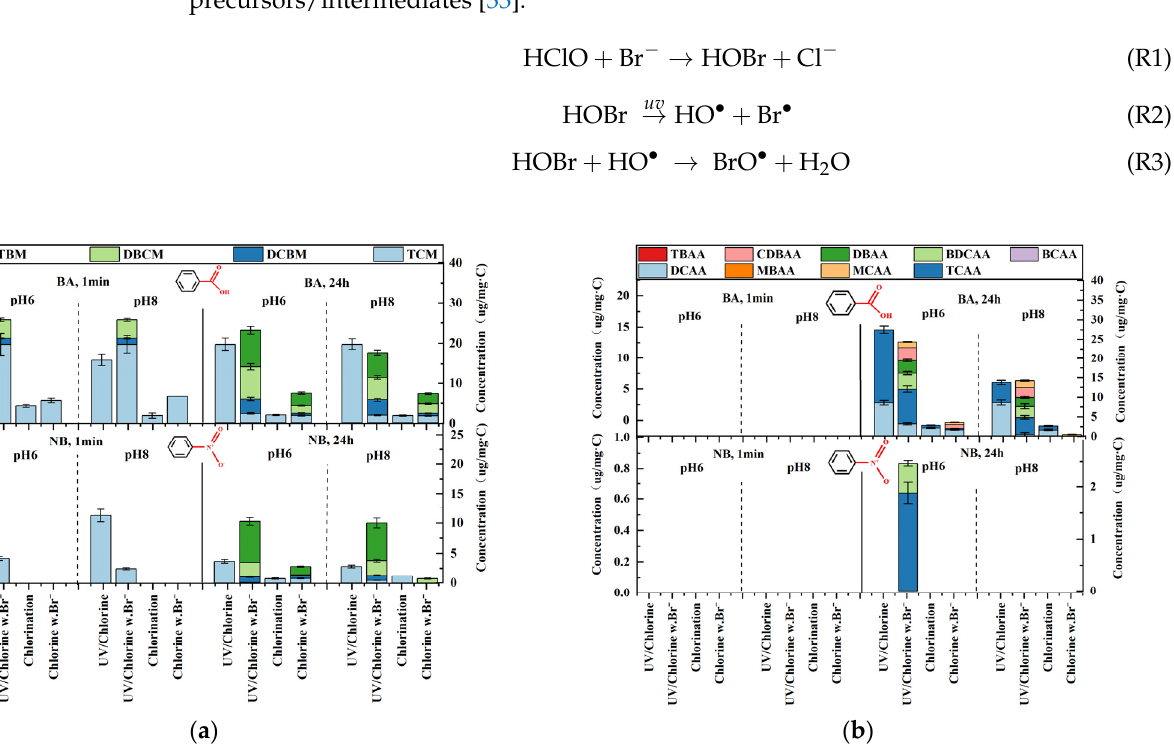
Figure 3. The formation of THMs ( a ) and HAAs ( b ) during the 1 min short-term oxidation and after 24 h post-chlorination from two inert benzene derivatives. Short-term oxidation conditions: Chlorine dose = 10 mg chlorine /L, pH = 6.0 or 8.0, [model benzene precursors] 0 = 3 mg-C/L, UV fluence rate = 10 mW/cm 2 , [bromide] 0 = 1 mg/L. Post-chlorination conditions: pH = 8.0, chlorination time = 24 h, chlorine residual = 1.0 ± 0.4 mg/L, dark, 22 °C. Table 4. Bromine incorporation factors of THMs and HAAs from the seven benzenes under the following conditions: Chlorine dose = 10 mg Cl 2 /L, pH = 6.0 or 8.0, [model benzene precursors] 0 = 3